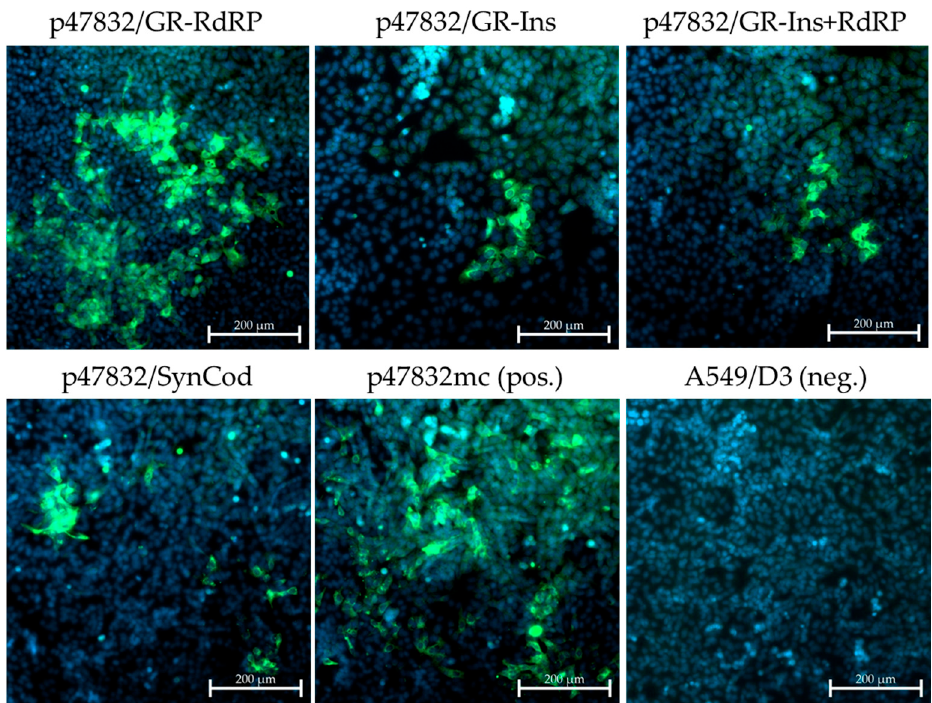
Figure 6. Generation of A549/D3 cell lines persistently infected with viruses generated from the constructs. The indicated constructs were transfected into BSR T7/5 cells and the resulting cell lysate was used for infection of A549/D3 cells. After an initial incubation for two weeks, the cells were split and seeded into new culture flasks, which was repeated every week. Cells from the 4th passage are shown, which were analyzed by immunofluorescence using an HEV capsid protein-specific antiserum. Green signal: HEV capsid protein, blue signal: nuclear DAPI staining. Scale bar: 200 µm. Table 1. Summary of the generation of HEV 47832c mutants based on the capsid protein detection by immunofluorescence analysis of cells. (+) positive, (-) negative.